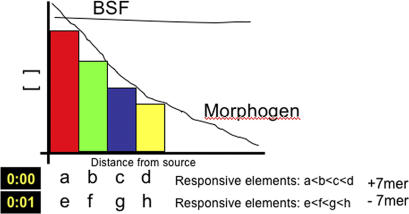
Proposed Mode of Action for the 7mer/BSF Interaction in Timing the Response to a Morphogen GradientA maternally provided morphogen, for example, Dorsal, activates target gene expression in a concentration-dependent manner, defining distinct developmental units (colored rectangles). Gene a, whose enhancer has the lower affinity for this particular morphogen, is expressed only at the higher concentration of the gradient. Gene d, whose enhancer has the higher affinity, is expressed also at a lower concentration. The 7mer sequence can time the response to this gradient while maintaining the spatial information. Because the 7-mer alone is not able to activate transcription (Figure 6), it can function as a timer linking the spatial gradient with the temporal regulation. For example, the 7mer sequence contained in the 5′ regulatory region of gene a would allow gene a to be expressed before gene e within the same spatial unit (red). This regulatory mode can operate along both the dorsal-ventral (D-V) and anterior-posterior (A-P) axes because it would not interfere with the positional information encoded in the gradient itself. Indeed the 7mer and its variants are particularly enriched in enhancers bound by Dorsal (D-V) and Bicoid (A-P).